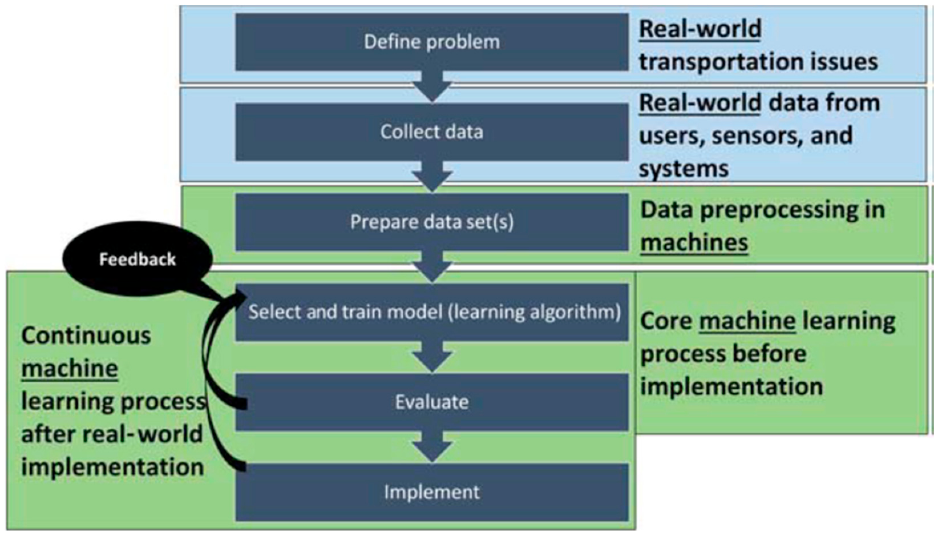
Figure 4. Machine learning algorithm steps.